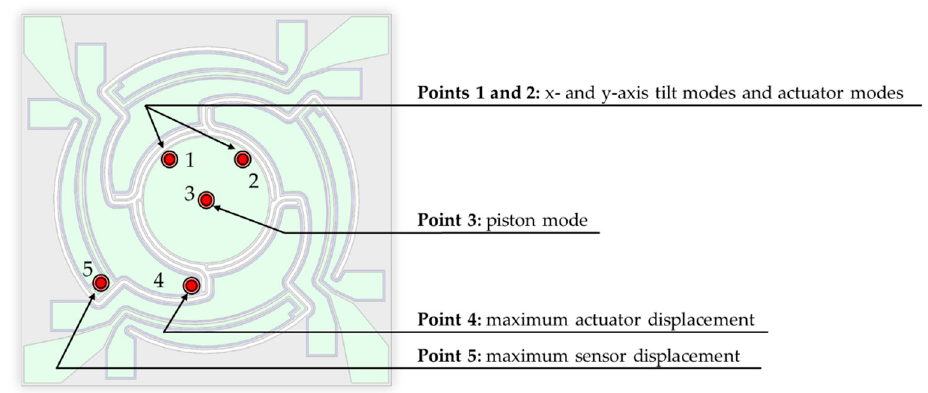
Figure 17. Measurement points for displacement determination.